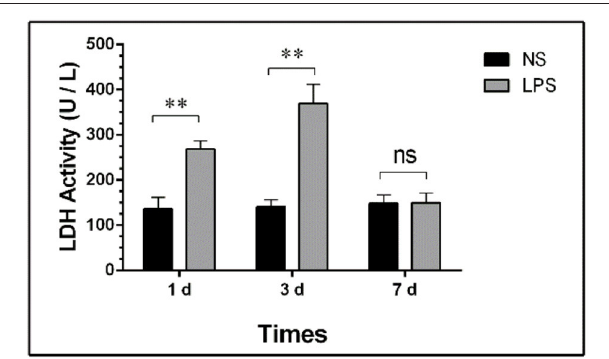
FIGURE 2 | Total protein in BALF of LPS-induced ALI. Mice were sacrificed on days 1 and 3 after LPS stimulation and BALF were collected for protein quantification. BALF, bronchoalveolar lavage fluid; LPS, lipopolysaccharide; ALI: Acute lung injury; * p < 0.05; ** p < 0.01; ns, no statistical significance. Statistical results were an average of five animals in each group.